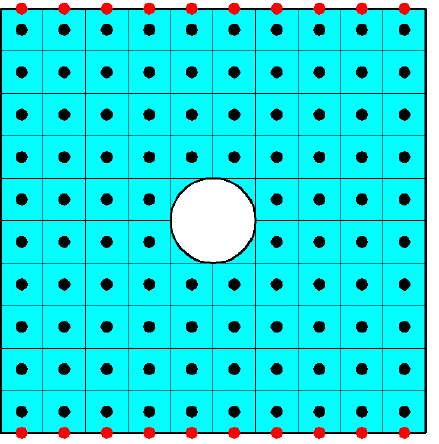
Figure 21. The discretization of the square plate.